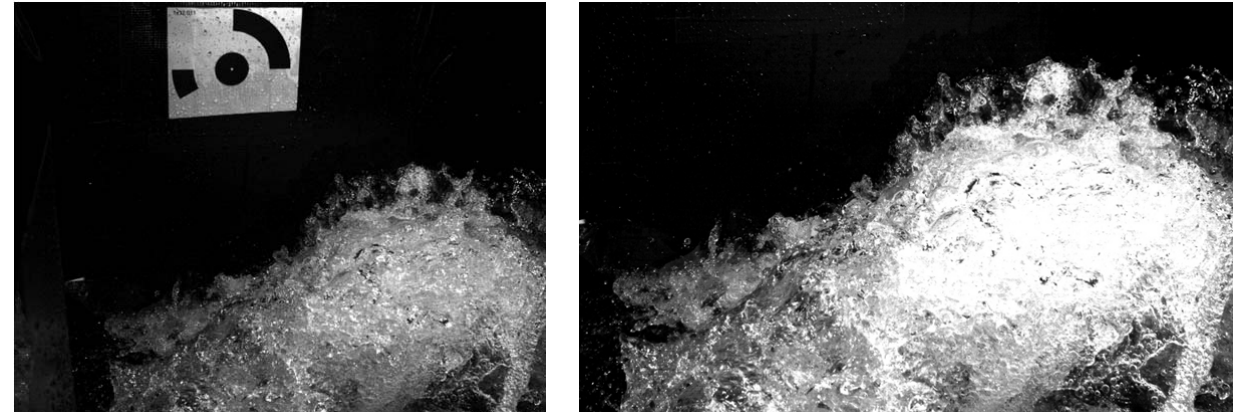
Figure 8. Photo before removing markers (left) and after removing markers and enlightening flow